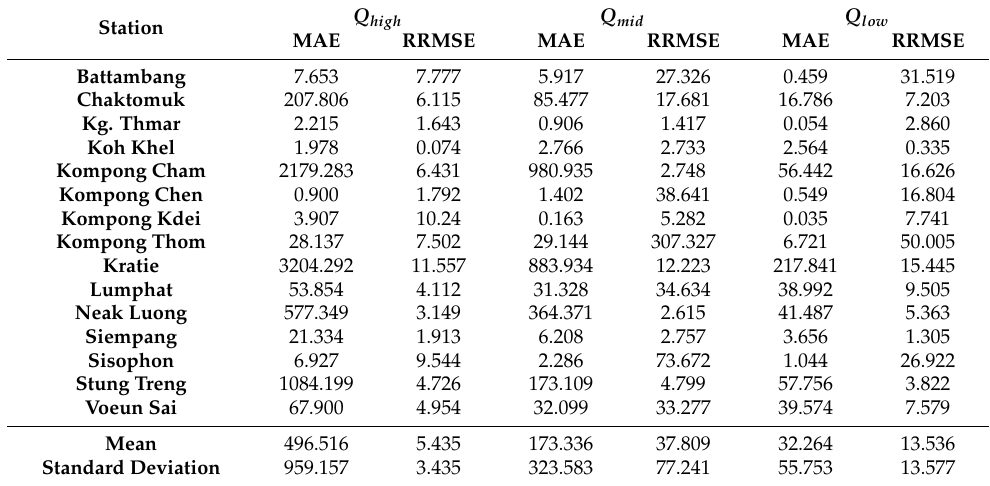
Table 6. The table lists the Mean Absolute Error (MAE) and Relative Root Mean Squared Error (RRMSE) for the stations’ high, mid, and low flows. The high flows are the flows equal to or above the 80th percentile, the low flows are the flows equal to or below the 20th percentile, while in between high and low flows are the mid flows. The unit of Q is m 3 /s.